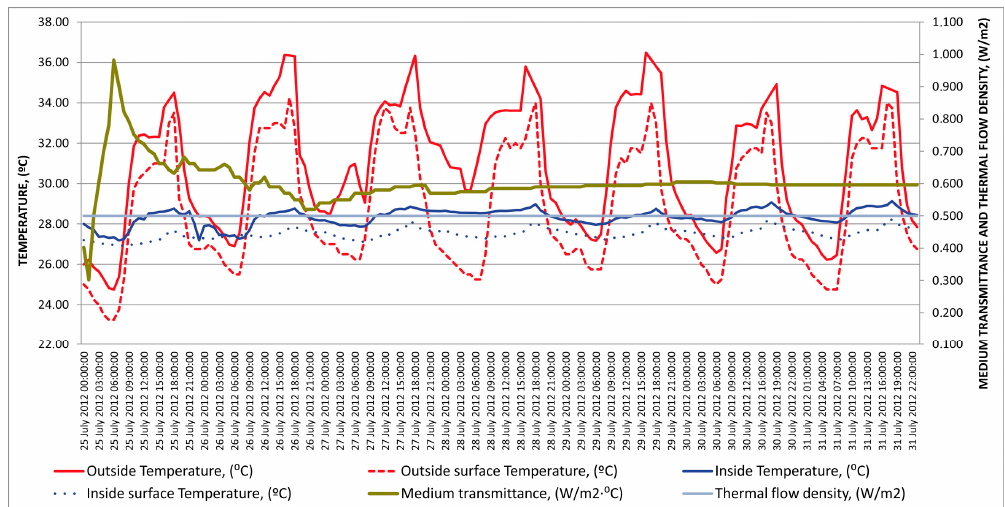
Table 6. Results of U-values across different scenarios.